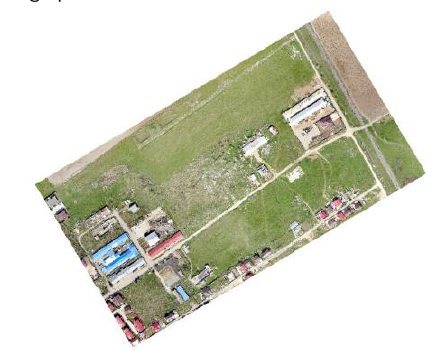
Figure 1. The study area in the Mogosoaia comune For these area, in less than 40 minutes we have collected 347 geo-referenced images. We processed the raster data and delivered the final products in order to used them in the geodesign